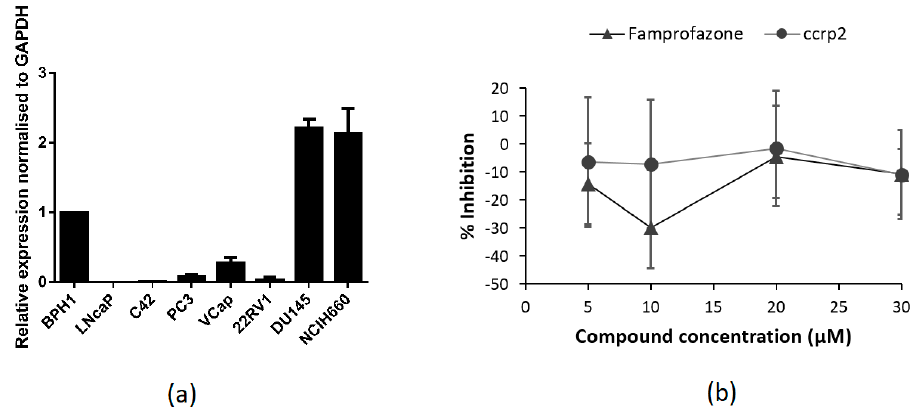
Figure 2. ( a ) Expression levels of TLX in PCa cell lines as measured by qRT-PCR. Error bars represent standard error of mean for two independent experiments performed in triplicates. ( b ) Compounds Famprofazone and ccrp2 known to activate transrepressive activity of TLX did not show dose-dependent inhibitory effect on 3XTAE-LUC reporter activity. Error bars represent standard deviation. Results were obtained from three independent experiments.